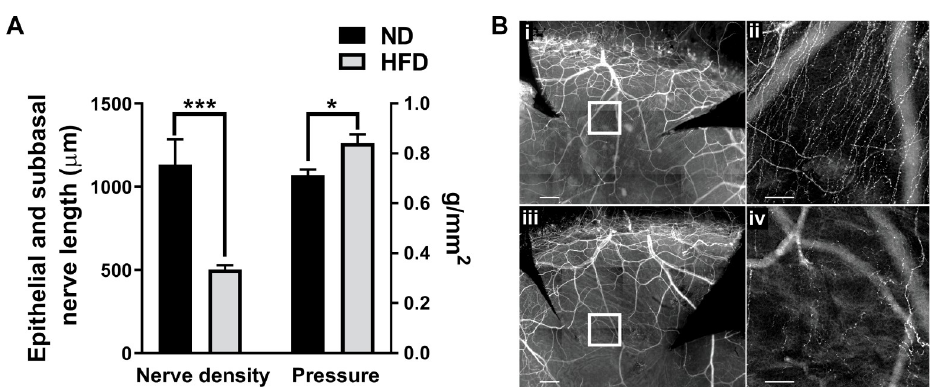
Fig 7. Healing nerves after corneal epithelial abrasion. Corneas from ND and HFD fed mice were analyzed after epithelial abrasion. (A) At 96h post-injury, nerve density (total axon length ( μ m) of the epithelial branches and subbasal plexus) recovery (left) in 10d HFD fed mice compared with those on the ND (n = 5 per group). Cochet- Bonnett aesthesiometry was used to assess corneal sensitivity to touch (g/mm 2 ) at 96h post-injury (right) in 10d HFD mice compared to ND mice (n = 6 per group). (B) Corneal whole mounts showing corneal nerves of ND (i, ii) and HFD (iii, iv) mice at 96h post-injury. Corneas were stained with anti- β -tubulin III and imaged at 10X (i, iii; scale bar = 200 μ m) or 20X (ii, iv; scale bar = 50 μ m) magnification. The center of each inset box (i, iii; shown enlarged) is 500 μ m from the center of the cornea (ii, iv) because regenerating nerves have not yet reached the center in any of the mice. Data shown as means ± SEM. � p < 0.05, ��� p <